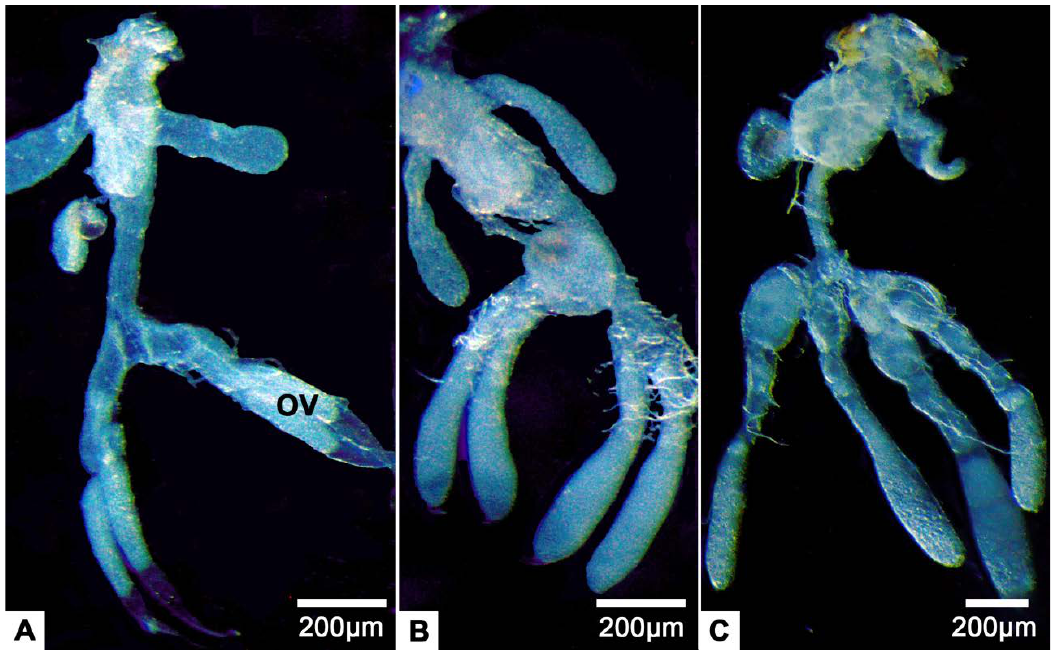
Figure 3. ( A – C ) The female reproductive system of T. klimeschi on the first, eighth and sixteenth day post-eclosion, respec- tively. Ovary (OV).